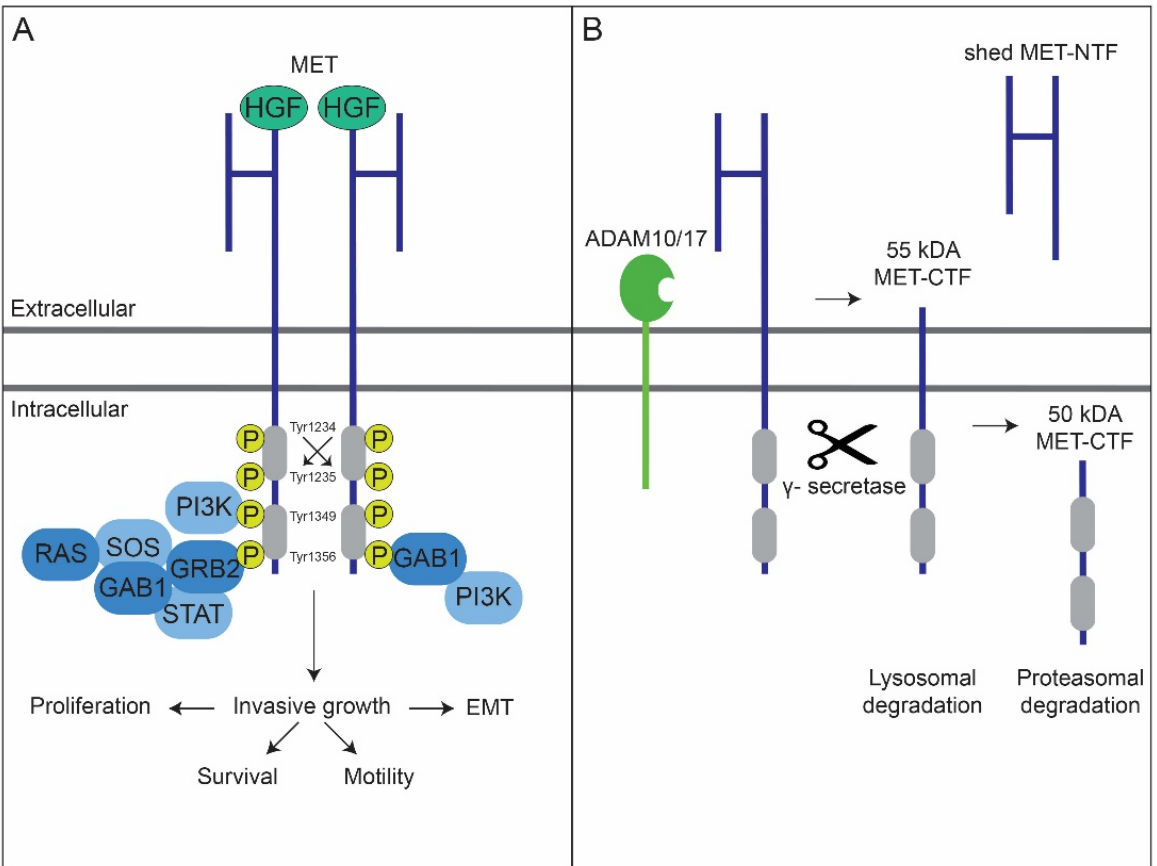
Figure 1. HGF/MET signaling facilitated invasive growth and presenilin-regulated intramembrane proteolysis (PS-RIP) mediated receptor downregulation. ( A ) Upon binding by its extracellular ligand, hepatocyte growth factor/scatter factor (HGF/SF), MET signaling facilitates the biological pro- gram of invasive growth by activating a complex network of signaling cascades. During invasive